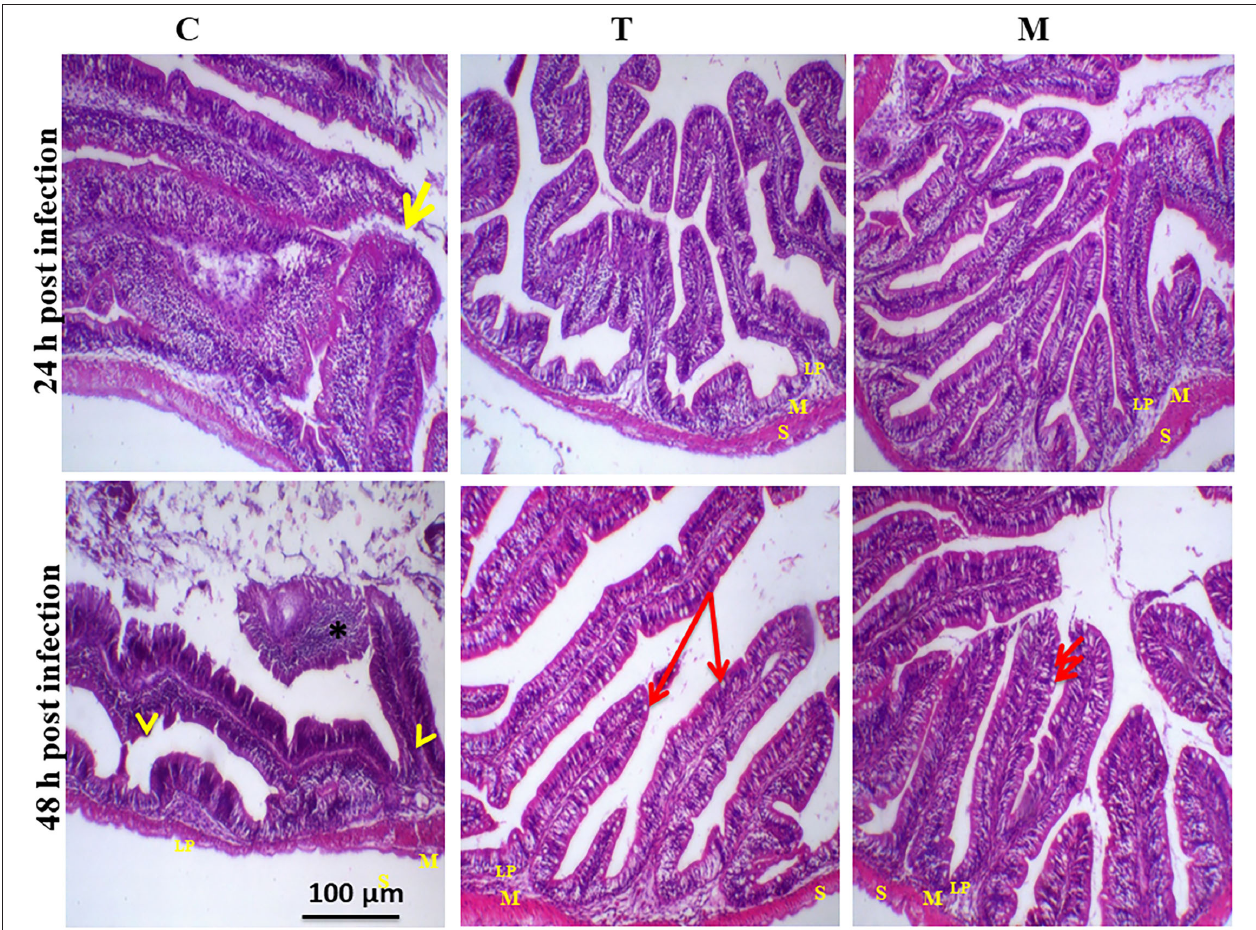
FIGURE 5 | H&E stained photomicrograph of mono-sex Nile tilapia mid-gut following 24 and 48h of A. hydrophila infection with and without moringa dietary inclusion. C, T, and M denote the 0, 5, and 10% moringa levels, respectively. The yellow arrow represents intestinal villi, yellow arrowhead indicates detachment of the apical part of enterocytes with leukocytic infiltration (star), while the red arrow represents goblet cells. M represents tunica muscularis, LP means lamina probria sub-mucosa, while S means tunica Serosa.